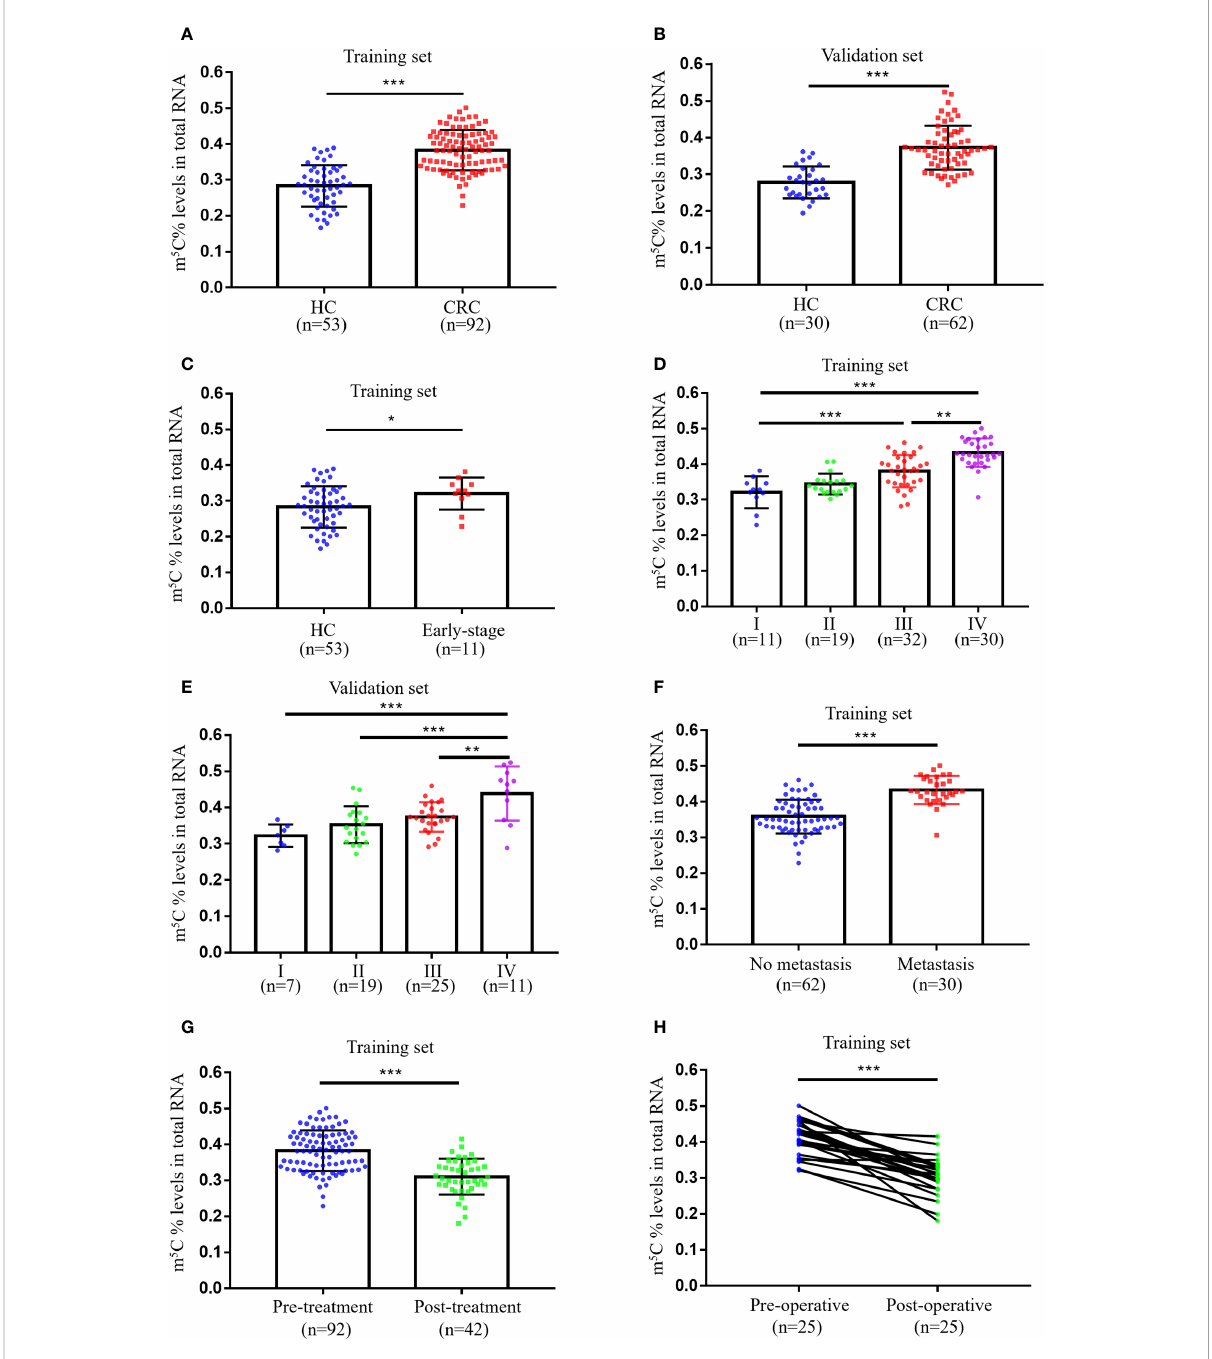
FIGURE 1 Levels of m 5 C in peripheral blood immune cells of CRC patients. (A) Levels of m 5 C in RNA of peripheral blood immune cells from HC (n=53) and CRC patients (n=92) in the training set. (B) Levels of m 5 C in RNA of peripheral blood immune cells from HC (n=40) and CRC patients (n=52) in the validation set. (C) Comparison of m 5 C levels in blood immune cells of HC (n=53) and early-stage CRC patients (n=11) in the training set. (D) m 5 C levels of blood immune cells in CRC patients at different clinical stages (stage-I, n=11; stage-II, n=19; stage-III, n=32; stage-IV, n=30) in the training set. (E) m 5 C levels of blood immune cells in CRC patients at different clinical stages (stage-I, n=7; stage-II, n=19; stage-III, n=25; stage-IV, n=11) in the validation set. (F) Comparison of blood m 5 C levels in CRC patients with (n=30) and without (n=62) distant-metastasis in the training set. (G) Comparison of blood m 5 C levels in CRC patients with (n=42) and without (n=92) treatment in the training set. (H) Levels of m 5 C in blood immune cells of CRC patients (n=25) before and after surgical resection treatment in the training set. Data are shown as mean ± SD; * P < 0.05, ** P < 0.01 and *** P <